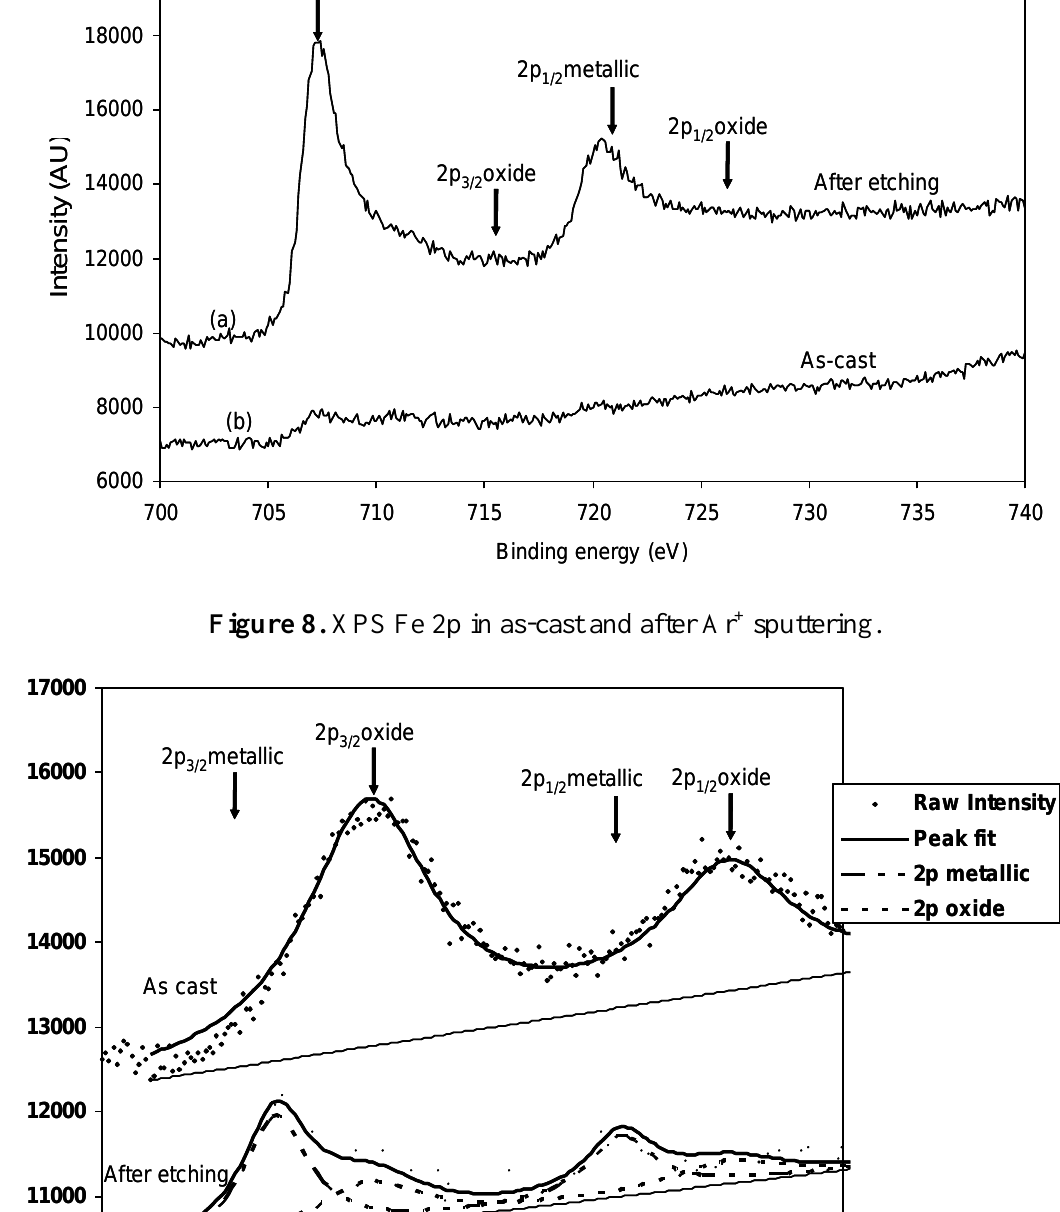
O for as-cast wire and after 2 3